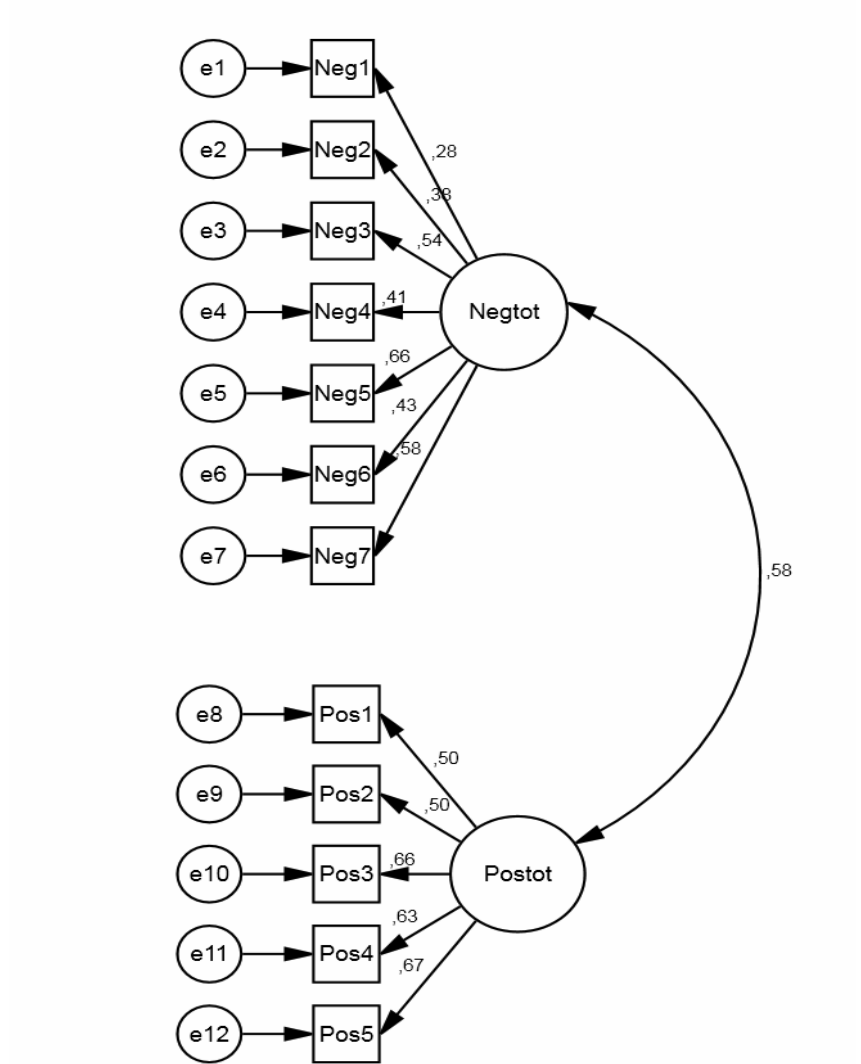
Figura 3. Modelo bifatorial de regulação: emoções positivas e emoções